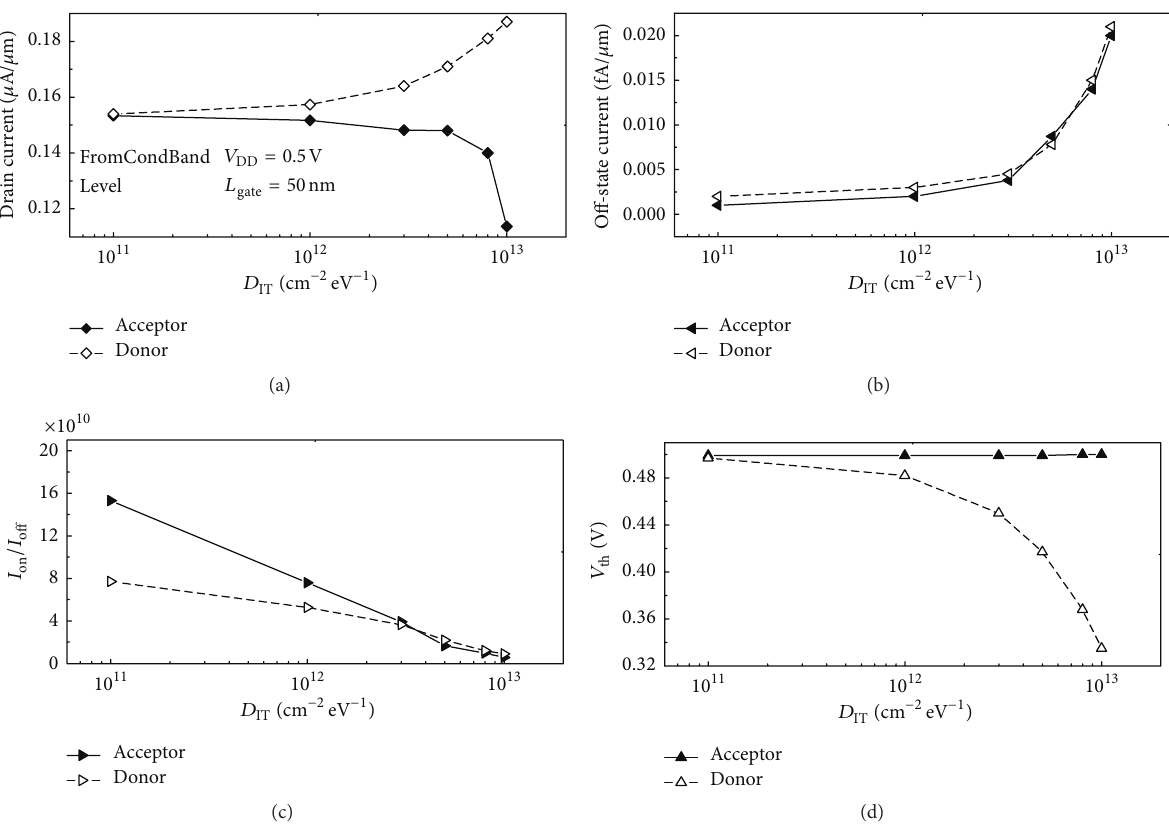
= 𝑉 = 0.5 V, (b) off-state 𝐼 at 𝑉 on GS DS